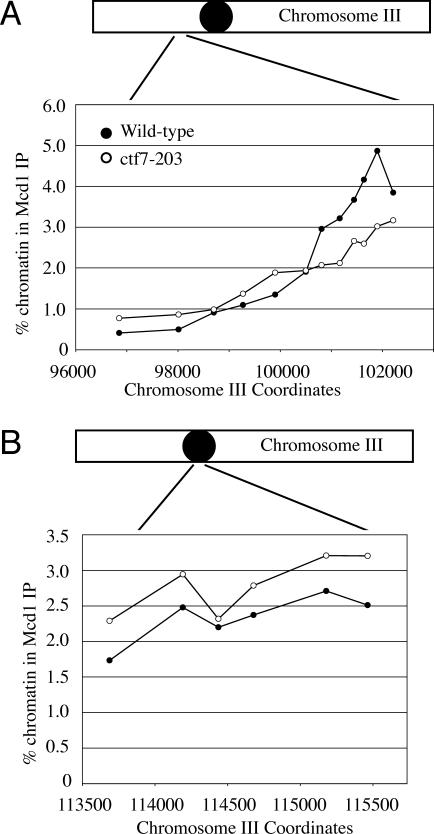
Ctf7 Functions after Cohesin Enrichment at CAR Sites and Pericentric RegionsWild-type CTF7 and temperature-sensitive ctf7–203 mutant cells containing Mcd1-HA were released from G1 in media at 37 °C with HU to inactivate ctf7 and to arrest cells in early S phase. Cells were processed for ChIP to assess cohesin binding at (A) CARC1 locus and (B) CENIII.